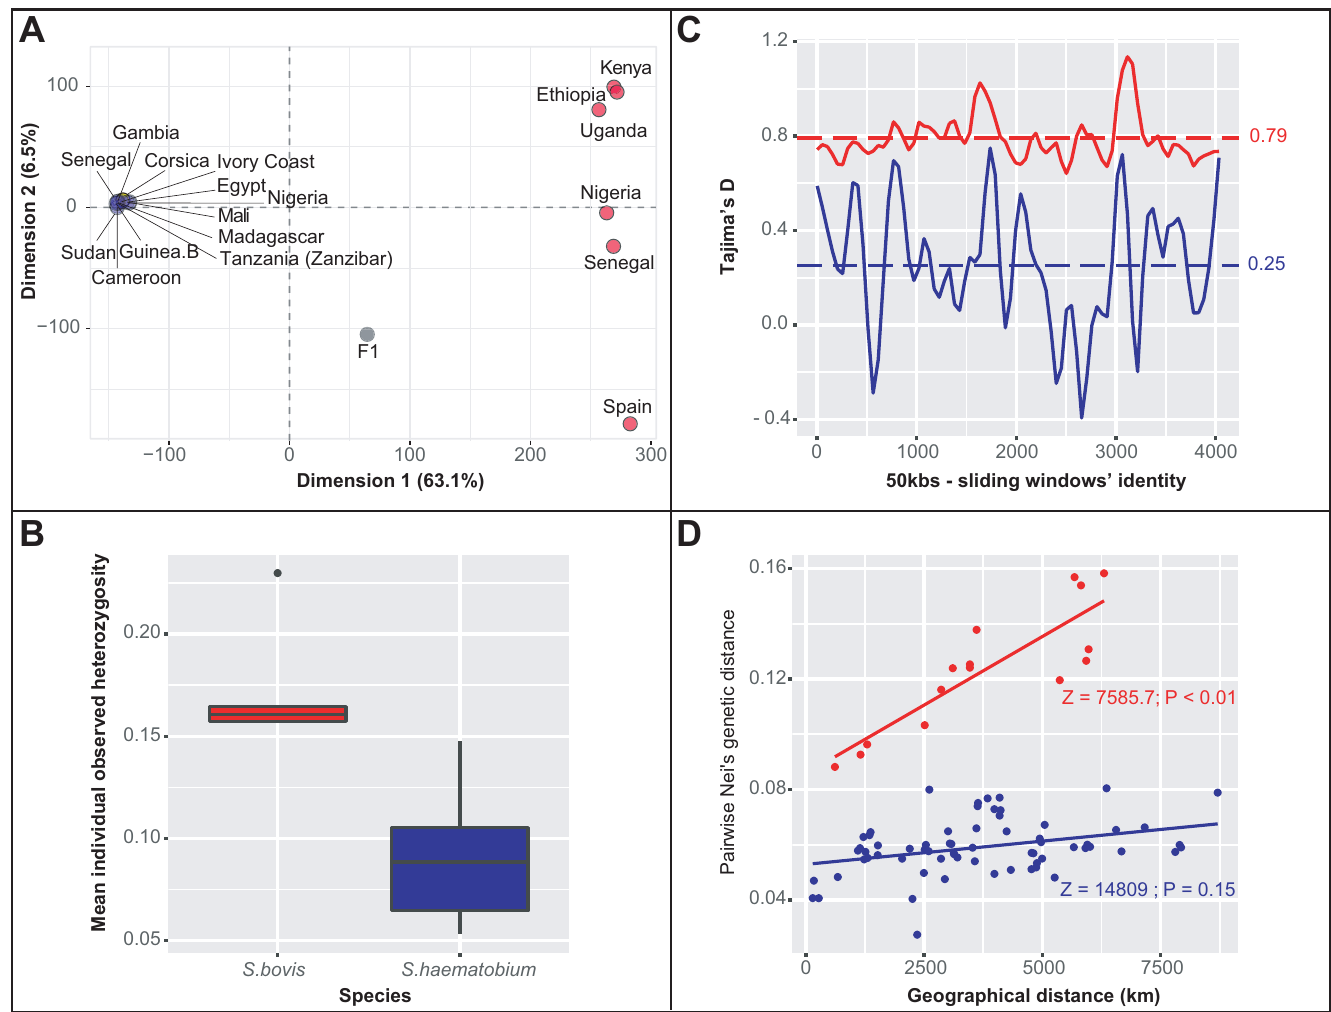
Fig 2. Genome-wide genetic diversity and genetic differentation within S . haematobium and S . bovis . A. Spatial representation of all isolates in a PCA dimension defined along the two first axis that explain 63.1% and 6.5% of the total genomic variance respectively. Isolates identified as S . haematobium are in blue, S . bovis isolates are in red, the Corsican hybrid is in yellow and the experimentally bred F1 hybrid is in grey. B. Mean individual heterozygosity within S . bovis (in red) and S . haematobium (including the Corsican lineage; in blue). C. Tajimas’D estimates along 4035 50 kbs-sliding windows that contained at least 8 SNPs over 159 scaffolds computed within S . bovis (in red) and S . haematobium (in blue). D. Plot of Nei’s distances computed between isolates and geographical distances between their countries of origin (using the countries’ centroid as proxy for each locality) within S . bovis (in red) and S . haematobium (in blue). The genomic structure among S . bovis lineages follows a classical significant isolation-by-distance pattern at the African continent